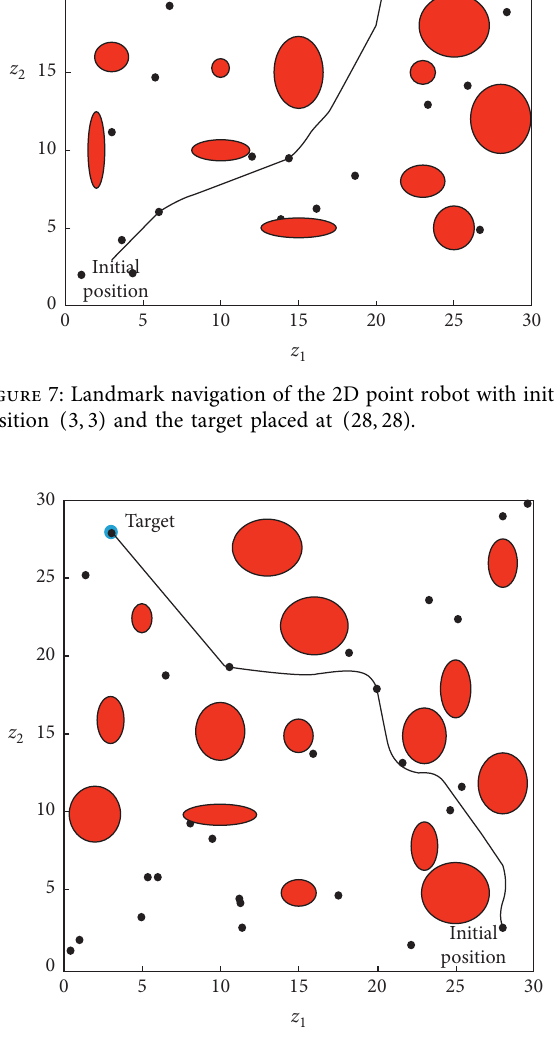
Figure 8: Landmark navigation of the 2D point robot with initial position ( 28 , 3 ) and the target placed at ( 3 , 28 ) .